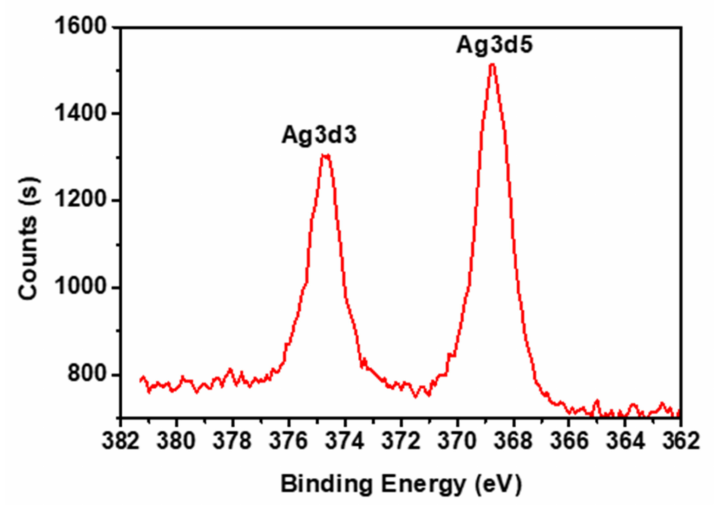
Figure 5. XPS analysis of Ag-2 sample.